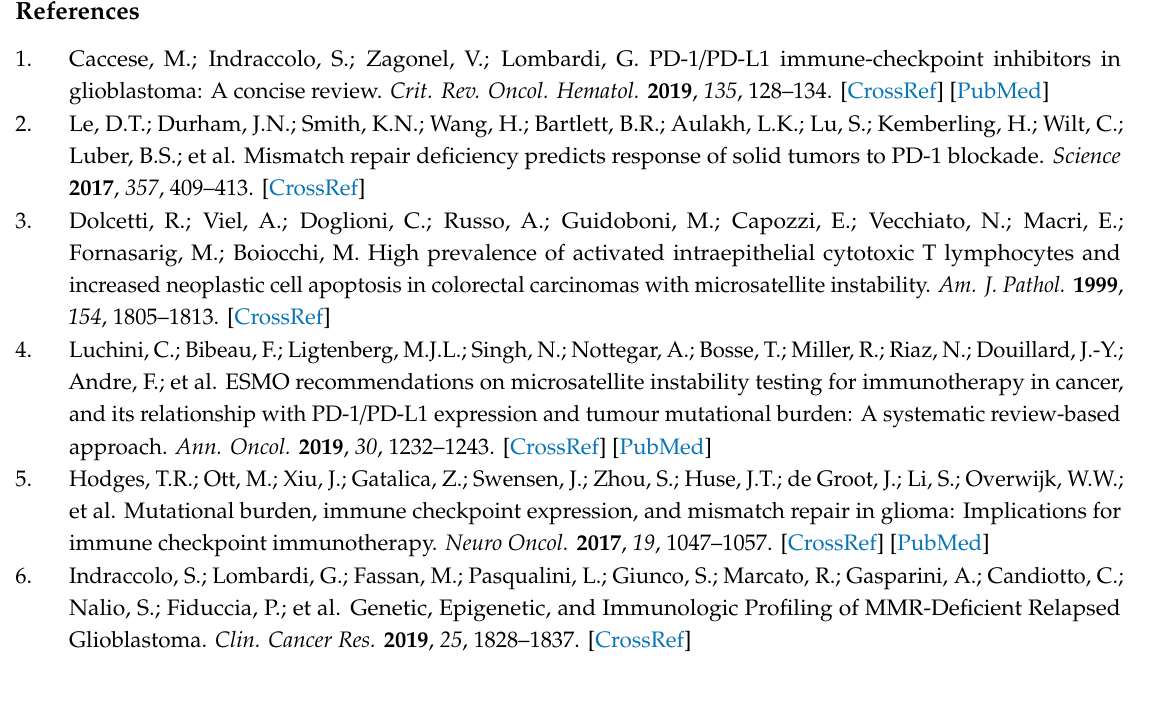
Figure S1: List of somatic and germline mutations identified in all 12 cases analyzed by next generation sequencing of 409 genes using the TML panel, Table S1: Baseline patient characteristics, Table S2: Patient immune-molecular characteristics, Table S3: Summary of gene alterations identified by sequencing analysis of 12 glioma cases, Table S4: Associations of molecular and immunological variables with disease control